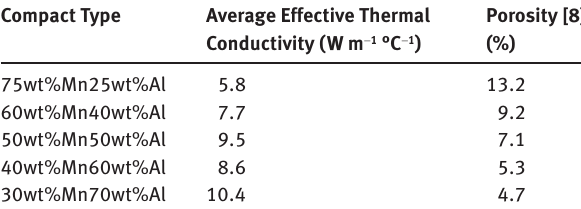
Fig. 16: Estimated Thermal Conductivity of a 30wt%Mn70wt%Al Compact